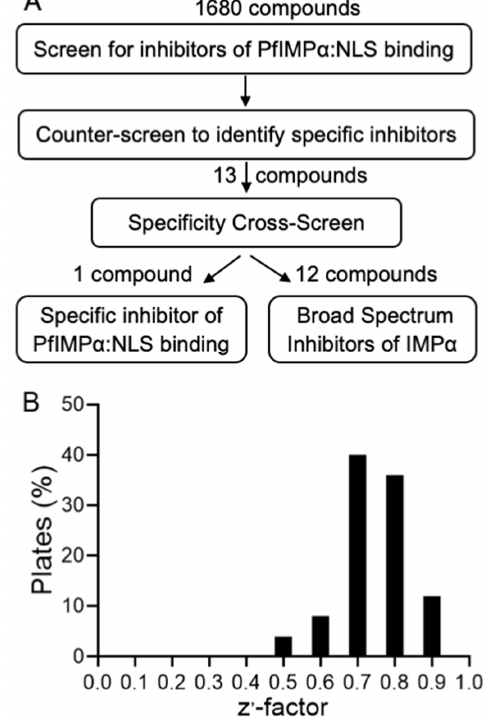
Figure 2. HTS to identify inhibitors of PfIMP α :NLS binding. ( A ) Schematic showing the strategy used to identify inhibitors of PfIMP α :NLS binding in the AlphaScreen system from the LOPAC and Pathogen Box libraries; the numbers of compounds at different stages of the screening/counter- screening process are indicated. ( B ) Plot of distribution of Z ′ factors for the HTS, calculated as previously [21–23,52], as a % of the number of plates.